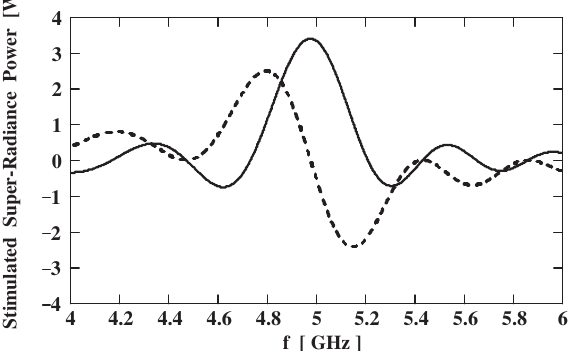
FIG. 4. Calculated stimulated superradiance power vs fre- quency from a prebunched e -beam. The e -beam current and energy are 0.2 A and 70 keV, respectively. The current modu- lation index is M J ¼ 0 . 2 and the input signal power is P in 2 W. The solid curve corresponds to ϕ q ¼ dashed curve corresponds to ϕ J ¼ π = 2